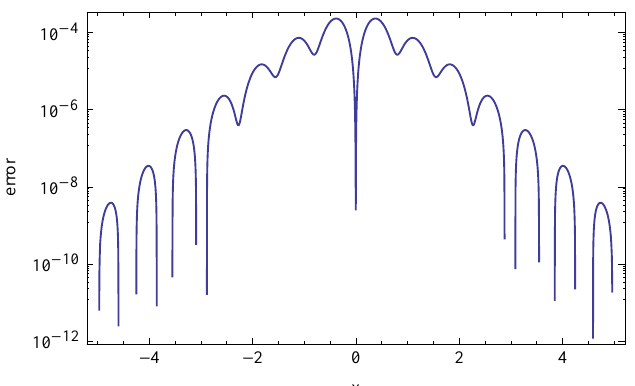
Figure 3. The difference between the ground state wave function calculated by using the local-global OPPQ method and the exact wave function Ψ gr.